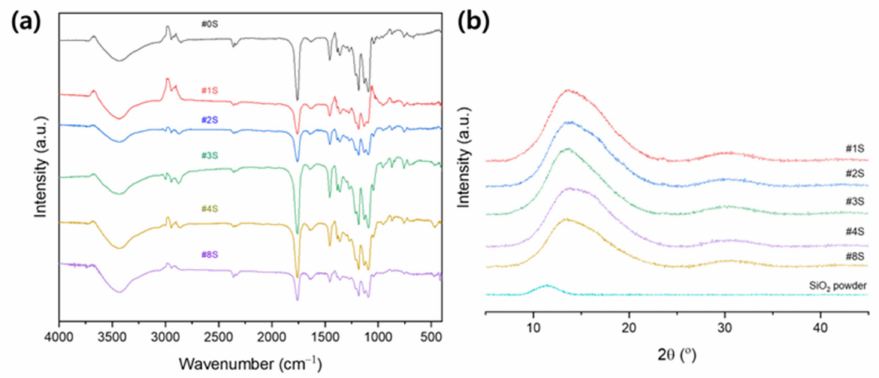
Figure 4. ( a ) FT-IR spectra and ( b ) XRD results of the SiO 2 powder and the electrospun PLA/PEG- PPG-PEG/SiO 2 nanofibrous adsorbents containing various concentrations of SiO 2